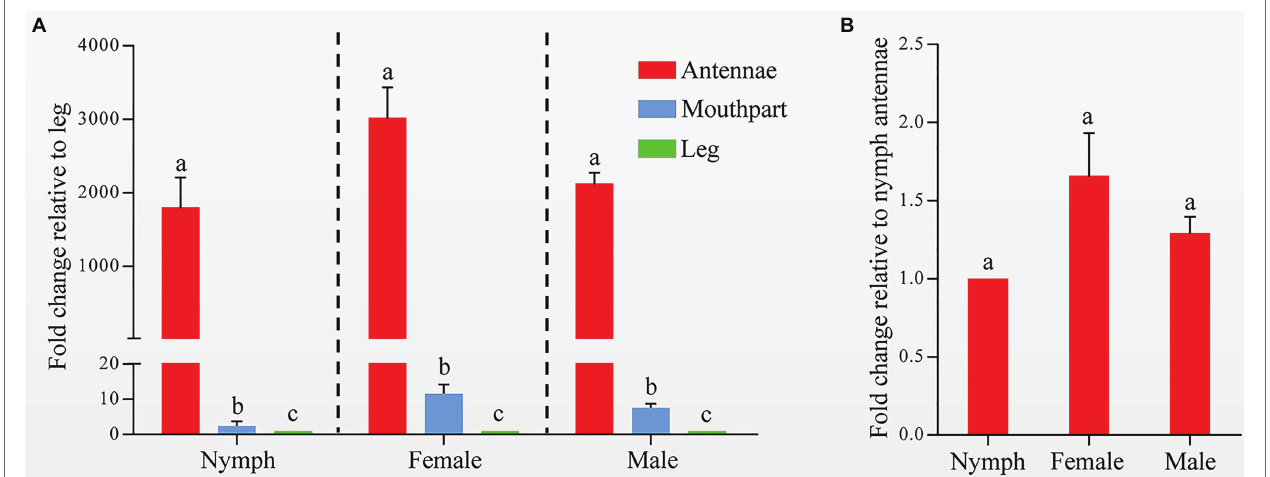
FIGURE 2 | (A) Expression profiles of the HhalCSP15 gene in different tissues (antennae, mouthpart, and leg) measured by quantitative real-time PCR (qRT-PCR). The fold changes are relative to the transcript levels in the leg. (B) Relative transcript levels of the HhalCSP15 gene in the antennae at different stages. The fold changes are relative to the transcript levels in the antennae of nymph. Reference genes: EF-1 α and Ubiquitin. The error bar and different letters represent the SE and significant differences, respectively ( p < 0.05).